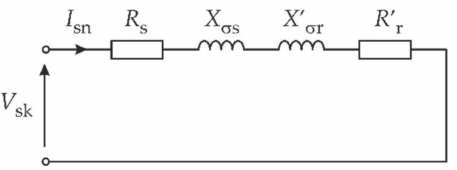
Figure 3. Circuit model of the RIM in the short-circuit